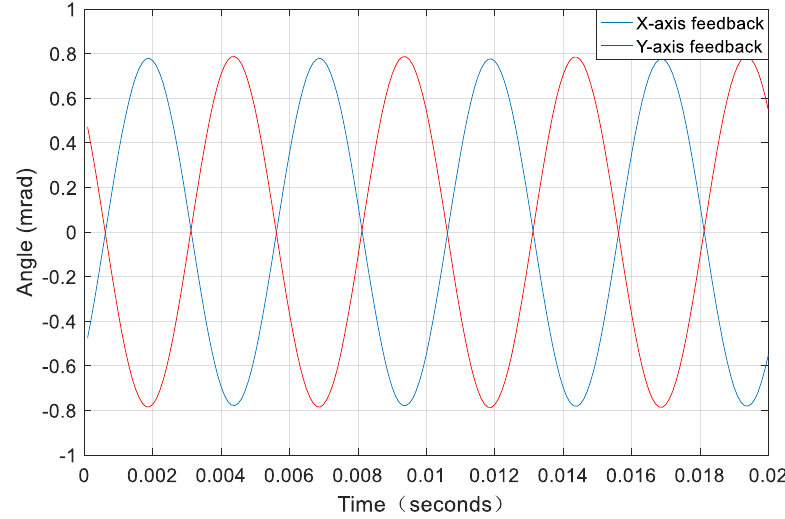
Figure 10. Phase difference test of 180 degrees of XY-axis double sinusoidal.